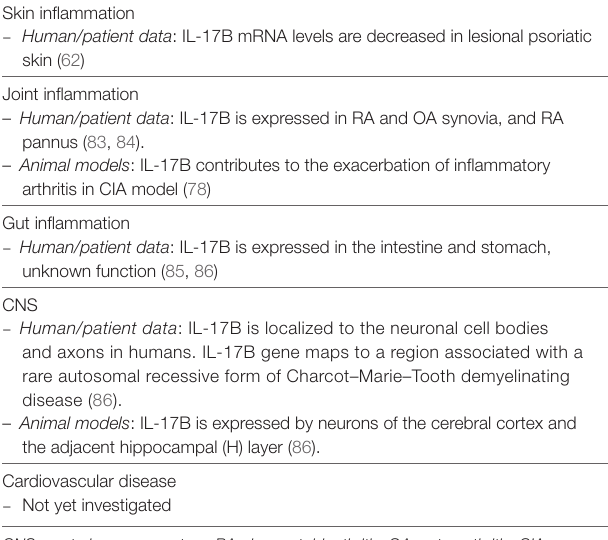
TABLe 3 | Overview of the role exerted by IL-17B in inflammation.